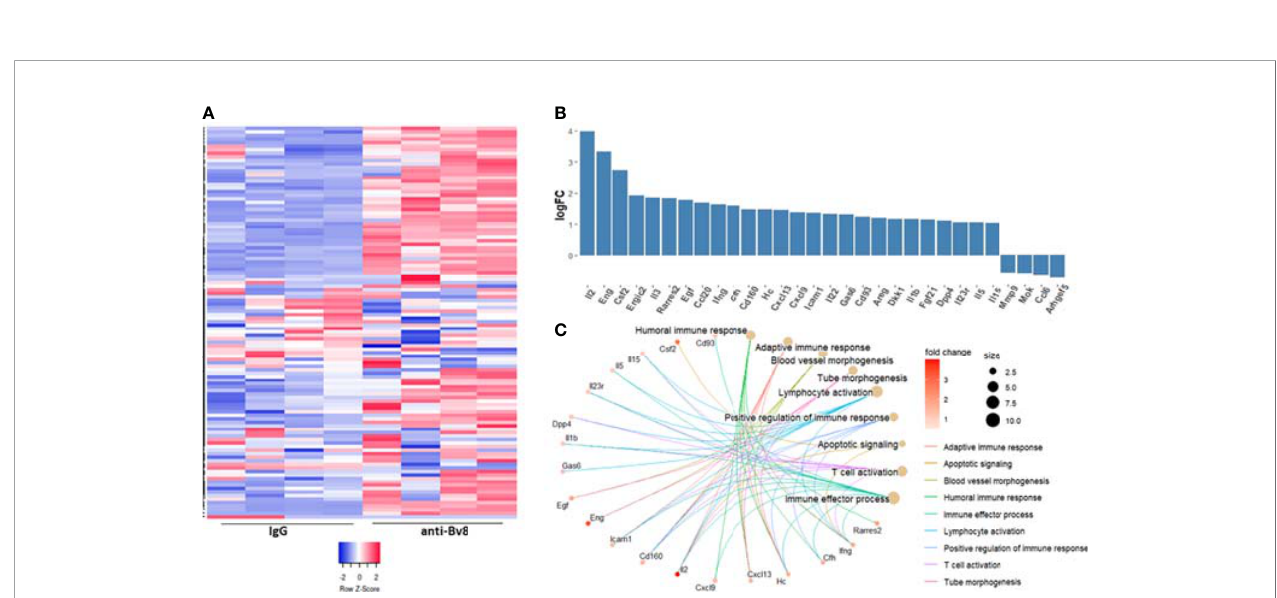
FIGURE 4 | Anti-Bv8 treatment inhibits the immunosuppressive function of MDSCs. (A, B) MDSC (Gr1+ cells) were isolated from the spleens of EMT6 tumor- bearing mice. The cells were cultured with anti-Bv8 or IgG control antibodies for 24 hours. Cell viability was assessed by 7AAD using fl ow cytometry, and presented by dot plot (A) followed by a summary graph (B) . (C) MDSCs and CD8+ T cells were isolated from the spleen of EMT6 tumor-bearing mice. MDSCs and CD8+ T cells were co-cultured in the presence of anti-Bv8 or IgG control antibodies, and T cell state was evaluated by fl ow cytometry. Shown are percentages of CD8+ T cells, activated CD8+ T cells, Effector/memory CD8+ T cells, naïve CD8+ T cells, proliferating CD8+ T cells, and granzyme B expressed in the co-culture media. (D, E) MDSCs and CD8+ T cells isolated from the spleen of EMT6 tumor-bearing mice (n=5 mice) were cultured with EMT6 cells as described in Materials and Methods. Tumor cell killing was assessed by fl ow cytometry (D) and Incucyte (E) . Representative images at the 10-hour timepoint are shown on the right. Scale bar= 100 m m. Statistical signi fi cance was assessed by one-way ANOVA followed by Tukey post-hoc test. Signi fi cant p values are shown as * p<0.05; ** p<0.01; *** p<0.001 from control or otherwise indicated in the fi